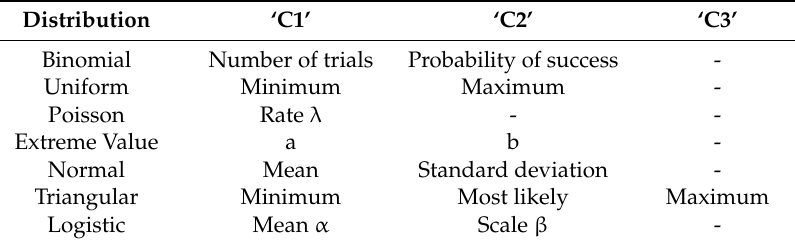
Table 4. Coefficients referred to for each distribution in Table 5.